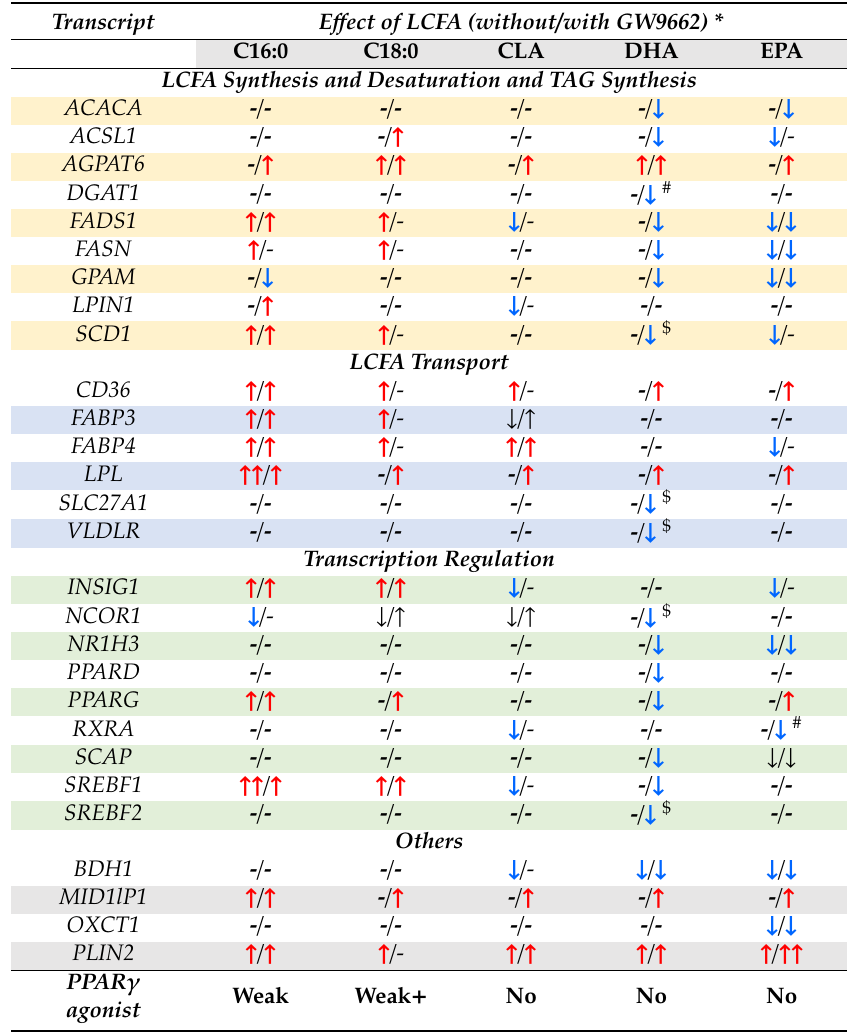
Table 2. Summary of the e ff ect of 12 h treatment of primary goat mammary epithelial cells with 100 µ